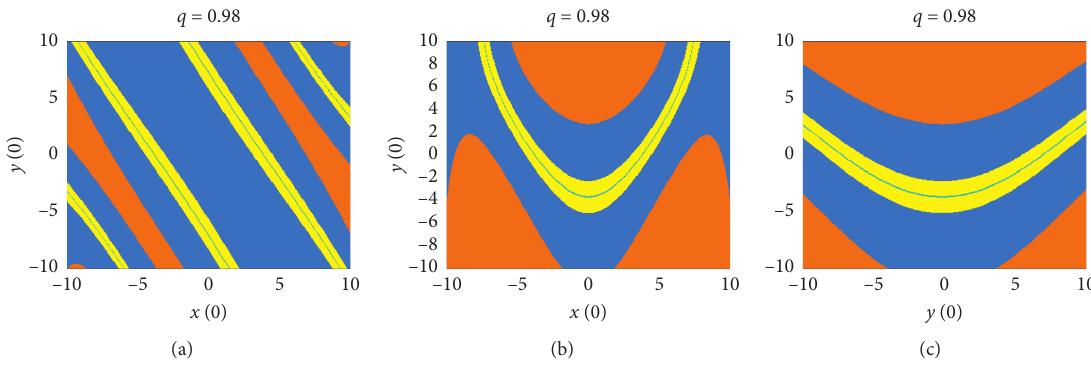
Figure 9: The basin of attraction of system (1) with q � 0.98: (a) x (0) − y (0) plane, (b) x (0) − z (0) plane, and (c) y (0) − z (0) plane.